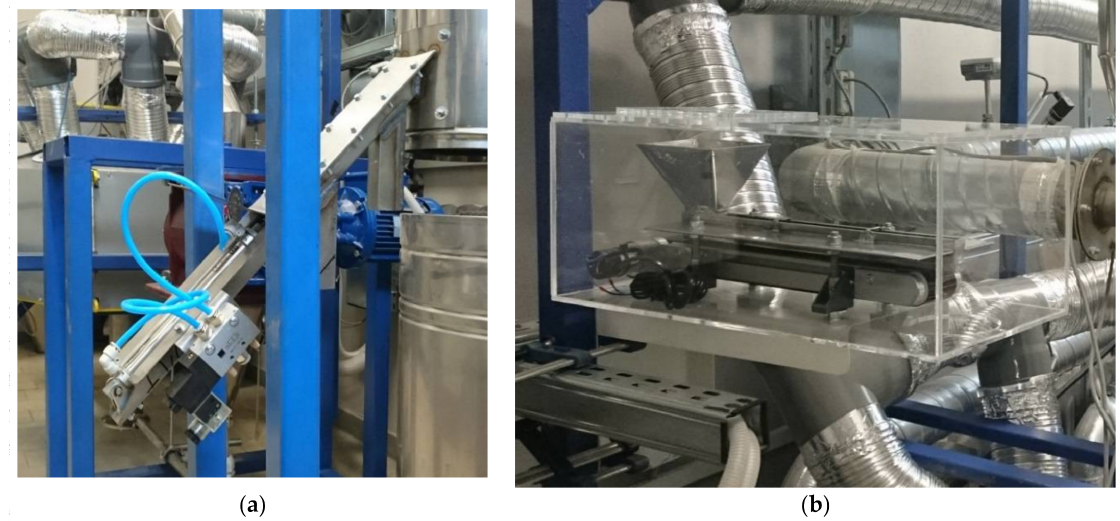
Figure 4. Sampling system ( a ) and system for automatic addition of the grinding media ( b ), both produced by Technet, Wancerz ó w,